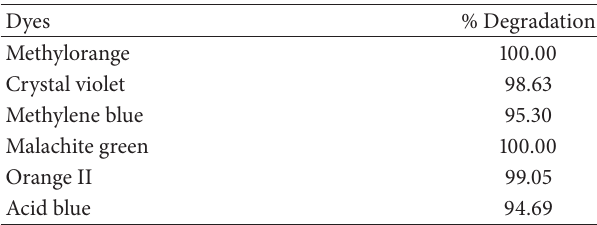
Table 1: Photodegradation of aquatic dye pollutants over Au NP doped TiO 2